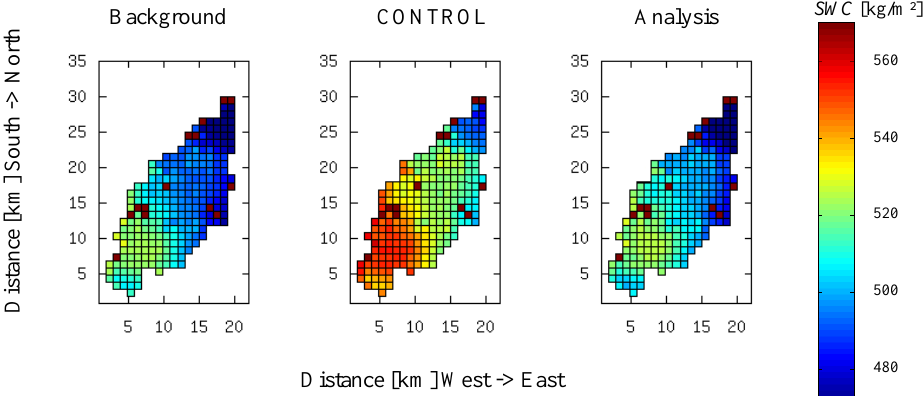
Fig. 8. TERRA-ML’s soil column is 2.43m deep. The soil water content (SWC) of each grid cell depends on its soil depth and its soil moisture (Eq. 9). The SWC is displayed for the initial time t =0 (5 May 1997) for the background, CONTROL and analysis. The analysis at t =0 was obtained assimilating streamflow from the CONTROL model simulation from Pforzheim from t =0 to t =56h with a 0.5 hourly timestep.